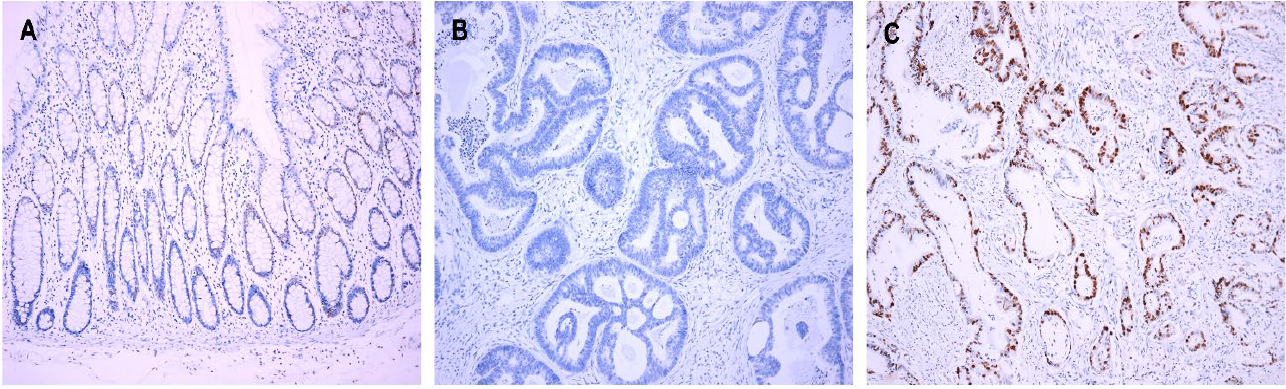
Figure 1. Cyclin D1 expression. ( A ) Expression in the transitional zone of the crypt at the lower part of the gland in the normal mucosa. ( B ) Cyclin D1 Low and ( C ) Cyclin D1 High in CRCs. Original magnification ×100.